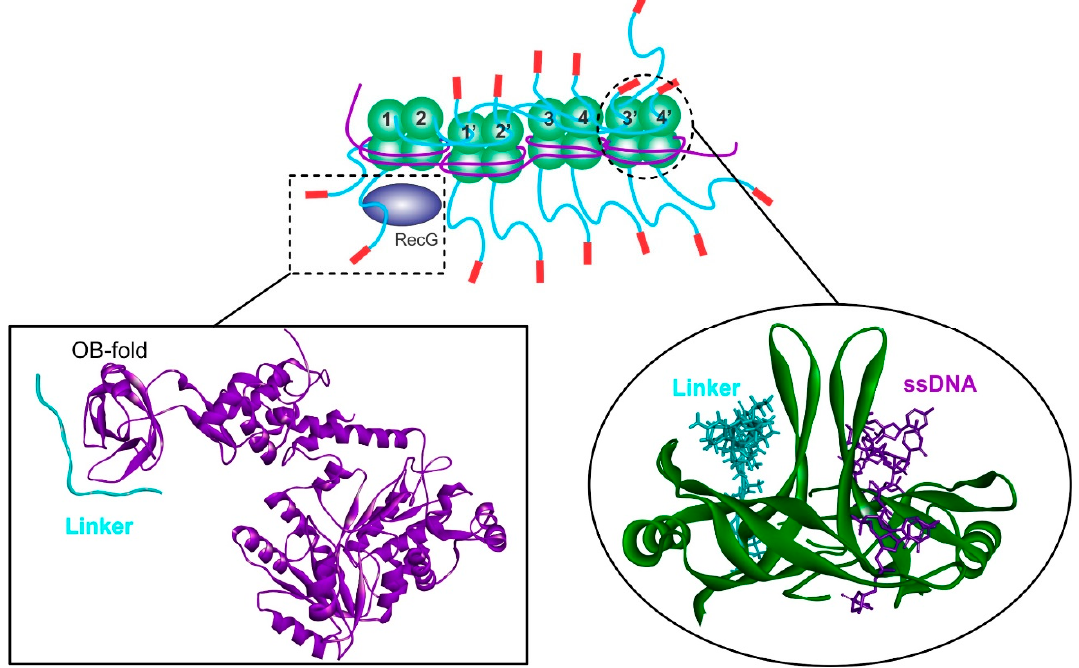
Figure 4. The linker/OB-foldnetwork of interactions is critical to SSB interactome function. Top, a schematic of an SSB-ssDNA complex demonstrating how the linker-OB-fold network of interactions produces a stable complex where the ssDNA is coated and protected. Here, the linker from the first tetramers bind to the OB-folds in adjacent tetramers, while other linkers are exposed and available for partner binding, in this case, RecG (left inset). Here, the helicase is presented as a ribbon diagram (purple) and a linker domain (cyan) is modeled into the OB-fold. When SSB-tetramers interact, some OB-folds are occupied by linker domains (cyan) while others bind ssDNA (purple). For clarity, only two monomers of the tetramer are shown and represented as ribbon diagrams (colored green). The schematic is adapted from [63].